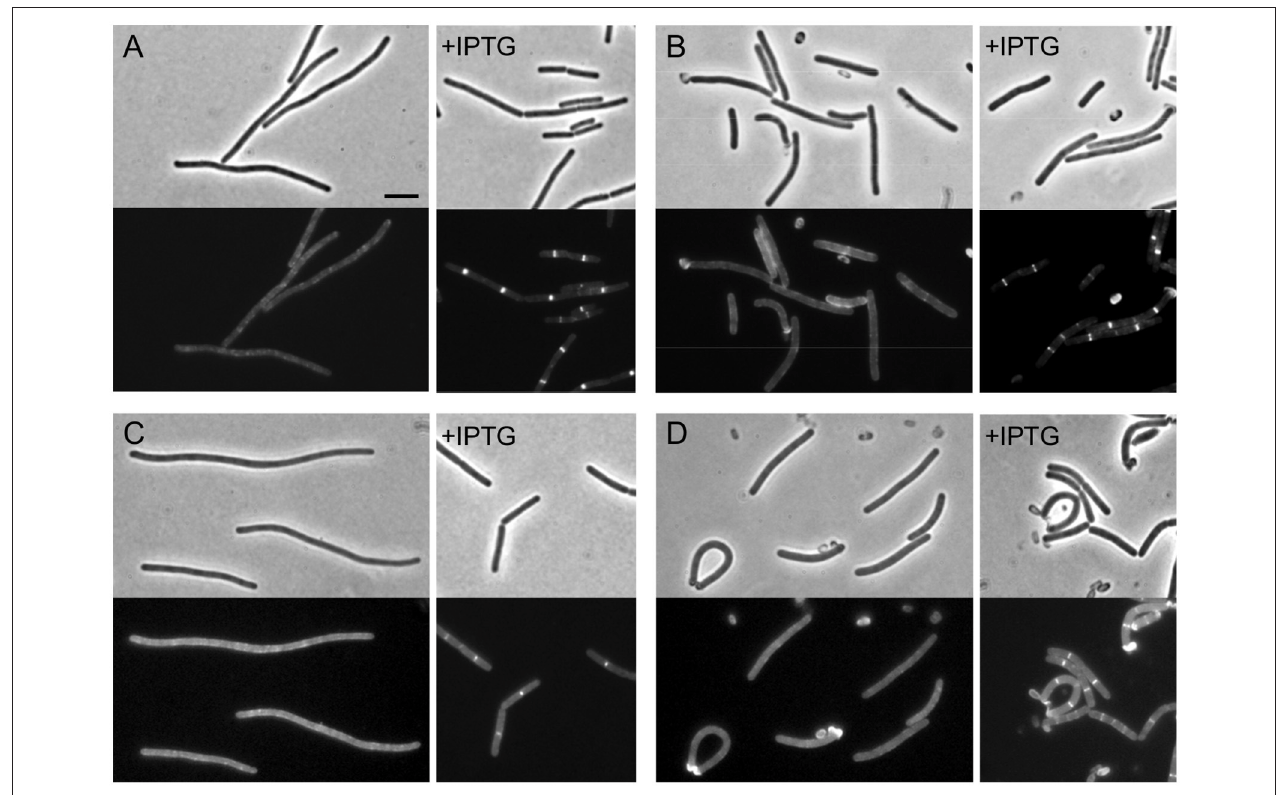
FIGURE 3 | The localization of PBP 2B and FtsL depend on FtsW. (A,B) Localization of PBP 2B in FtsW depleted cells and germinating spores. (A) Strain PG87 ( P spac -ftsW; P xyl -gfp-pbpB ) was grown at 37 ◦ C in competence medium in the presence of 0.5% xylose and in the absence or in the presence of 1 mM IPTG. Phase contrast and GFP images were taken 7 h after depletion ( ∼ 12 generations). (B) Spores of strain PG87 were heat shocked and germinated as described in the presence of 0.5% xylose and in the absence or in the presence of 0.5% xylose. Phase contrast and GFP images were taken 4 h after the beginning of germination. (C,D) Localization of FtsL in FtsW depleted cells and germinating spores. (C) Strain PG79 ( P spac -ftsW; P xyl -gfp-ftsL ) was grown at 37 ◦ C in competence medium in the presence of 0.5% xylose and in the absence or in the presence of 1 mM IPTG. Phase contrast and GFP images were taken 7 h after depletion ( ∼ 12 generations). (D) Spores of strain PG79 were heat shocked and germinated as described in the presence of 0.5% xylose and in the absence of 0.5% xylose. Phase contrast and GFP images were taken 4 h after the beginning of germination. Scale bar indicates 5 µ